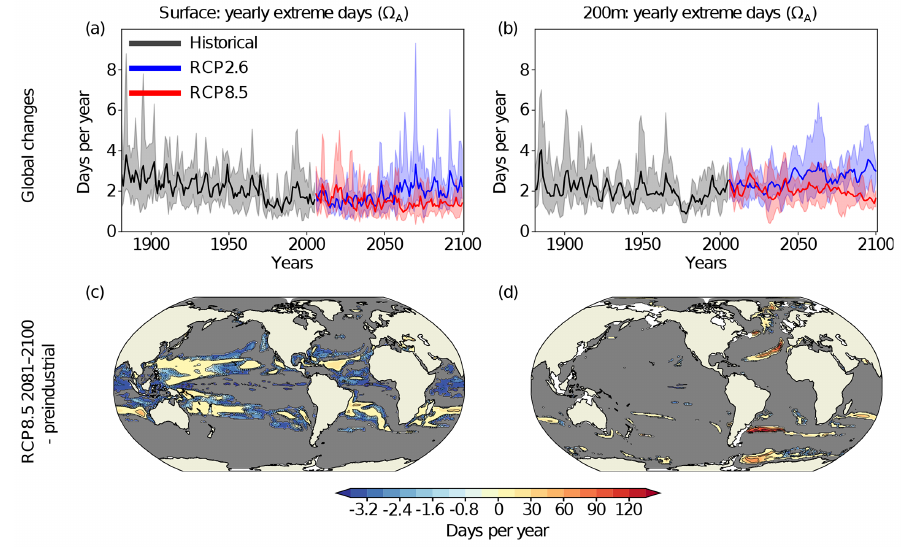
Figure 6. Simulated changes in the yearly number of (cid:127) A extreme days. The extreme events are defined with respect to a shifting baseline. Panels (a) and (b) show the globally averaged simulated yearly extreme days in (cid:127) A from 1881 to 2100 following historical (black lines) and future RCP2.6 (blue) and RCP8.5 (red) scenarios at the surface (a) and 200m (b) . The thick lines display the five-member ensemble means, and the shaded areas represent the maximum and minimum range of the individual ensemble members. Panels (c) and (d) show the simulated regional changes in yearly extreme days in (cid:127) A from the preindustrial period to 2081–2100 under the RCP8.5 scenario at the surface (c) and at 200m (d) . Shown are changes averaged over all five ensemble members. The black lines highlight the pattern structure and gray colors represent regions where no ensemble member simulates extremes during